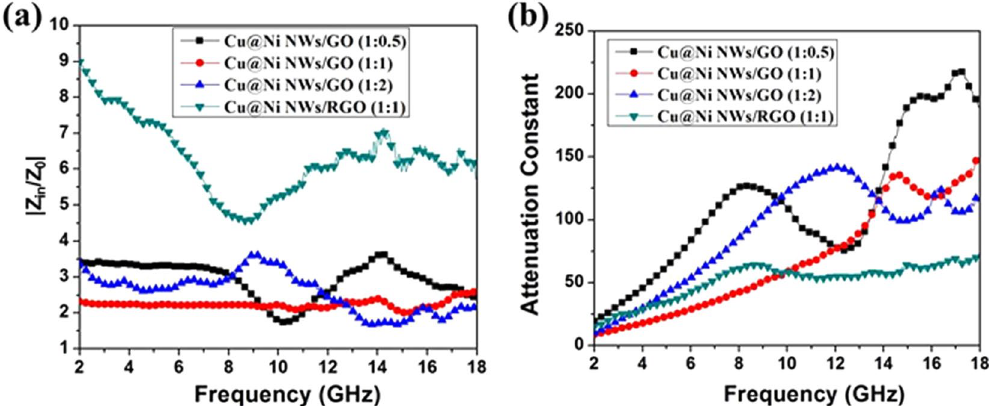
Figure 10. Impedance matching ( a ) and attenuation constant α ( b ) of Cu@Ni NWs/GO (1:0.5), Cu@Ni NWs/ GO (1:1), Cu@Ni NWs/GO (1:2), and Cu@Ni NWs/RGO